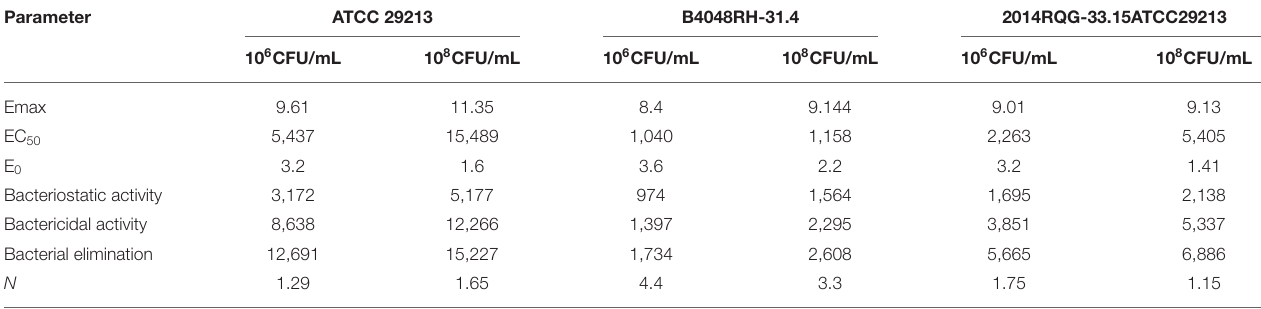
TABLE 2 | Integration of ex vivo PK/PD after administration of three consecutive IMM of cefquinome against in S.aureus . Parameter